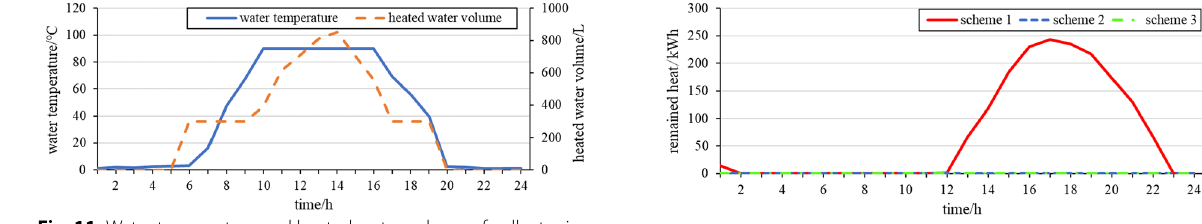
Fig. 14 Dynamic change of remaining heat of the tank in summer